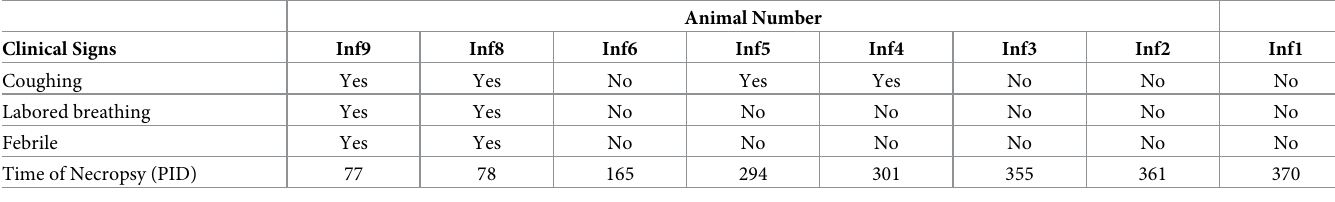
Table 1. Clinical signs of cattle inoculated via aerosol with 1.77 X 10 6 CFU of M . bovis strain